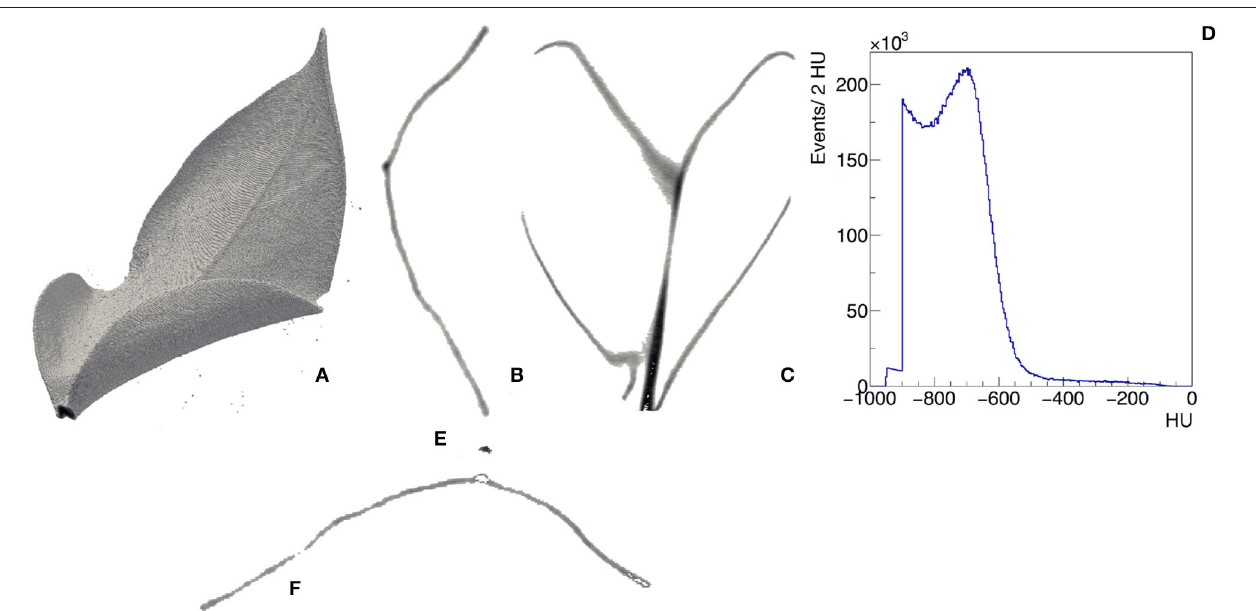
FIGURE 3 | Example of CT of a leaf of Epipremnum Aureum. 3D view (A) , transverse (B) , and longitudinal (C) slices with visible midrib and veins, distribution of the CT values in the leaf expressed in Hounsfield units (D) . Two regions can be identified from the analysis of the CT values: − 550 < HU < − 50 identifies the vascular system (E) and − 800 < HU < − 550 identifies the mesophyll (F)